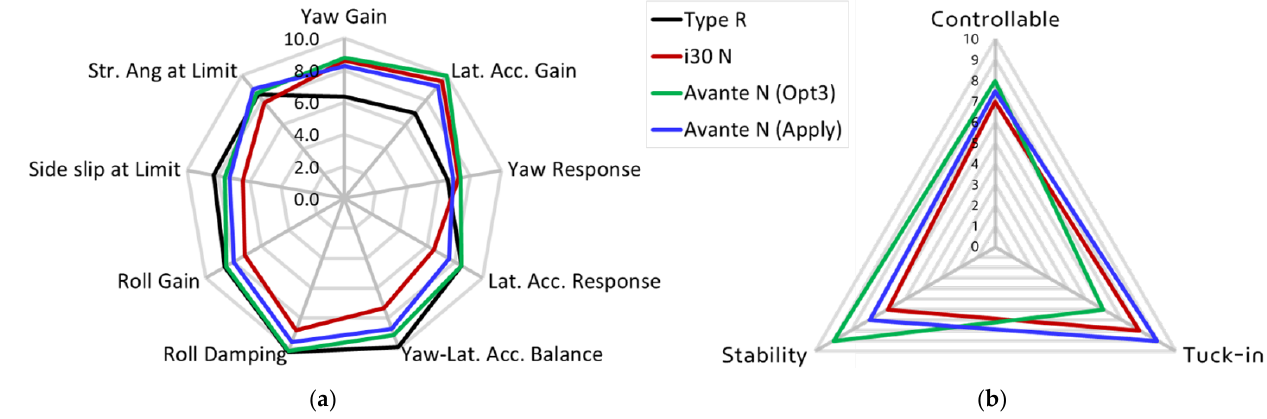
Figure 15. Avante N handling performance: ( a ) Handling performance (steering input); ( b )